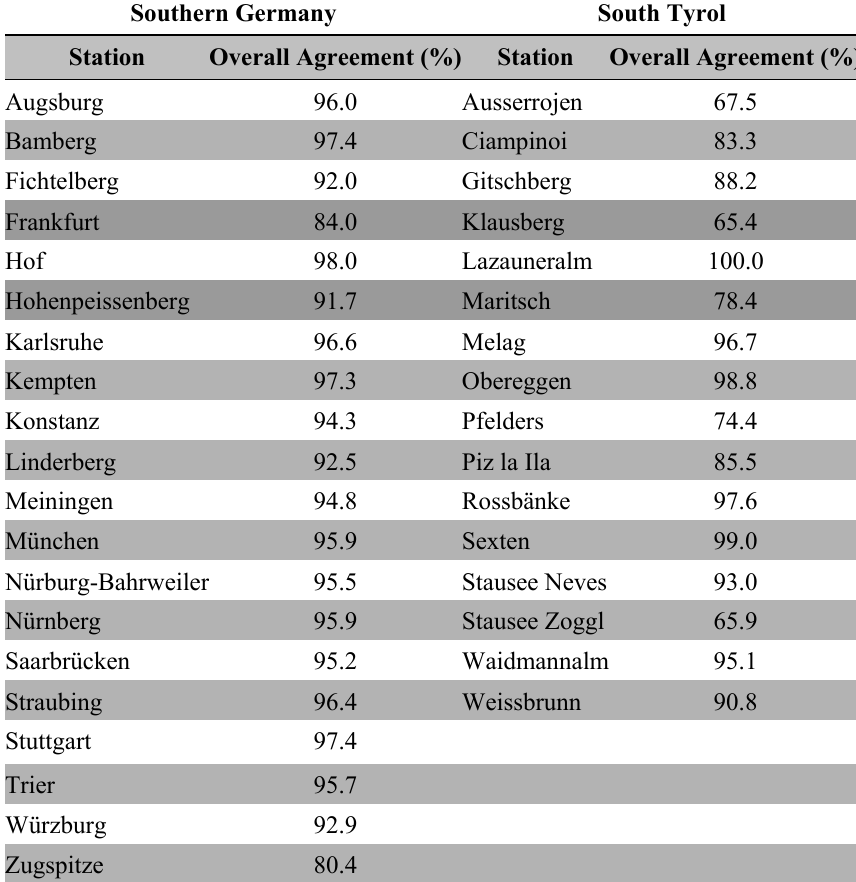
Table 6. Overall accuracies (OA) for single stations in Germany (left) and South Tyrol (right). Southern Germany South Tyrol Station Overall Agreement (%) Station Overall Agreement (%) Augsburg 96.0 Ausserrojen 67.5 Bamberg 97.4 83.3